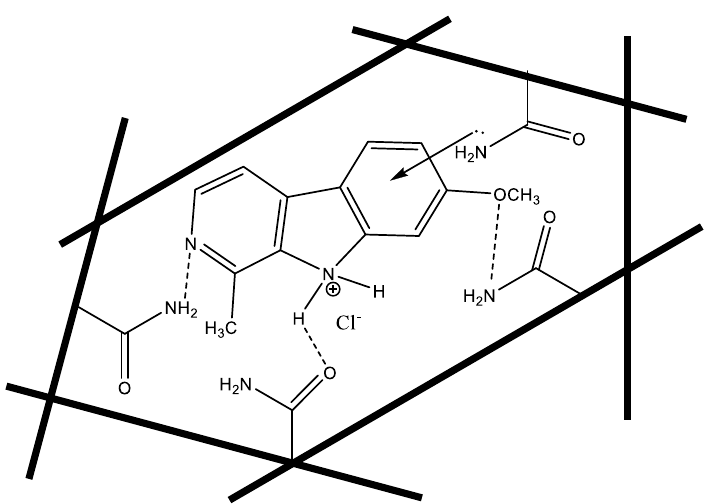
Figure 1. Non-covalent harmine